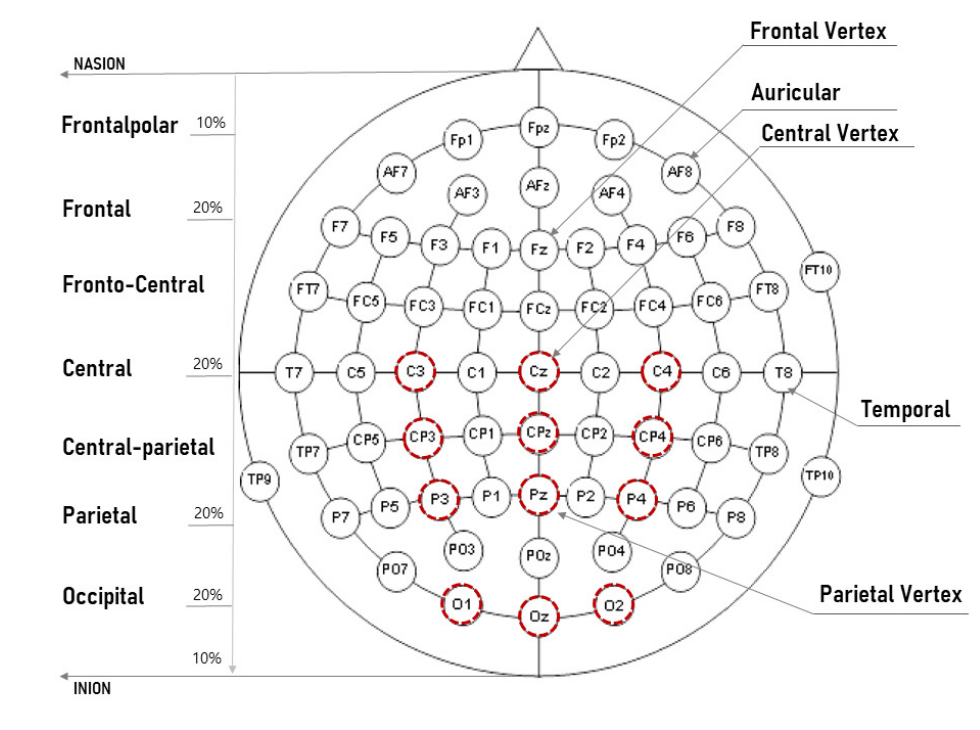
Figure 4. The red circle is the main analysis channel: The average value of the 12 channels was manipulated and